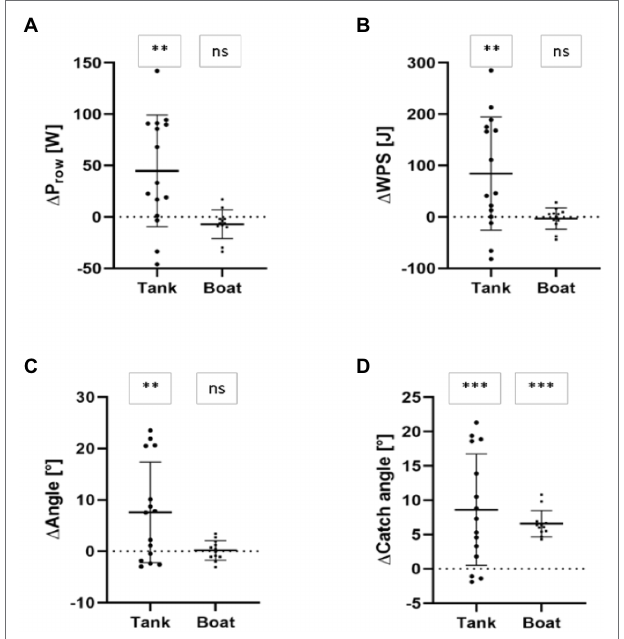
FIGURE 2 | Change scores of rowing power ( Δ P row ; A ), work per stroke ( Δ WPS; B ), total rowing angle ( Δ Angle; C ) and catch angle ( Δ Catch angle; D ) during indoor rowing tank and in-field boat measurements. Note: *** p < 0.001; ** p < 0.01; ns = not significant ( p > 0.05).